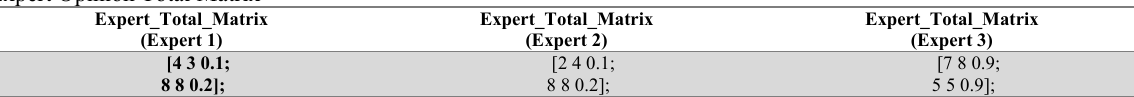
Expert Opinion Total Matrix